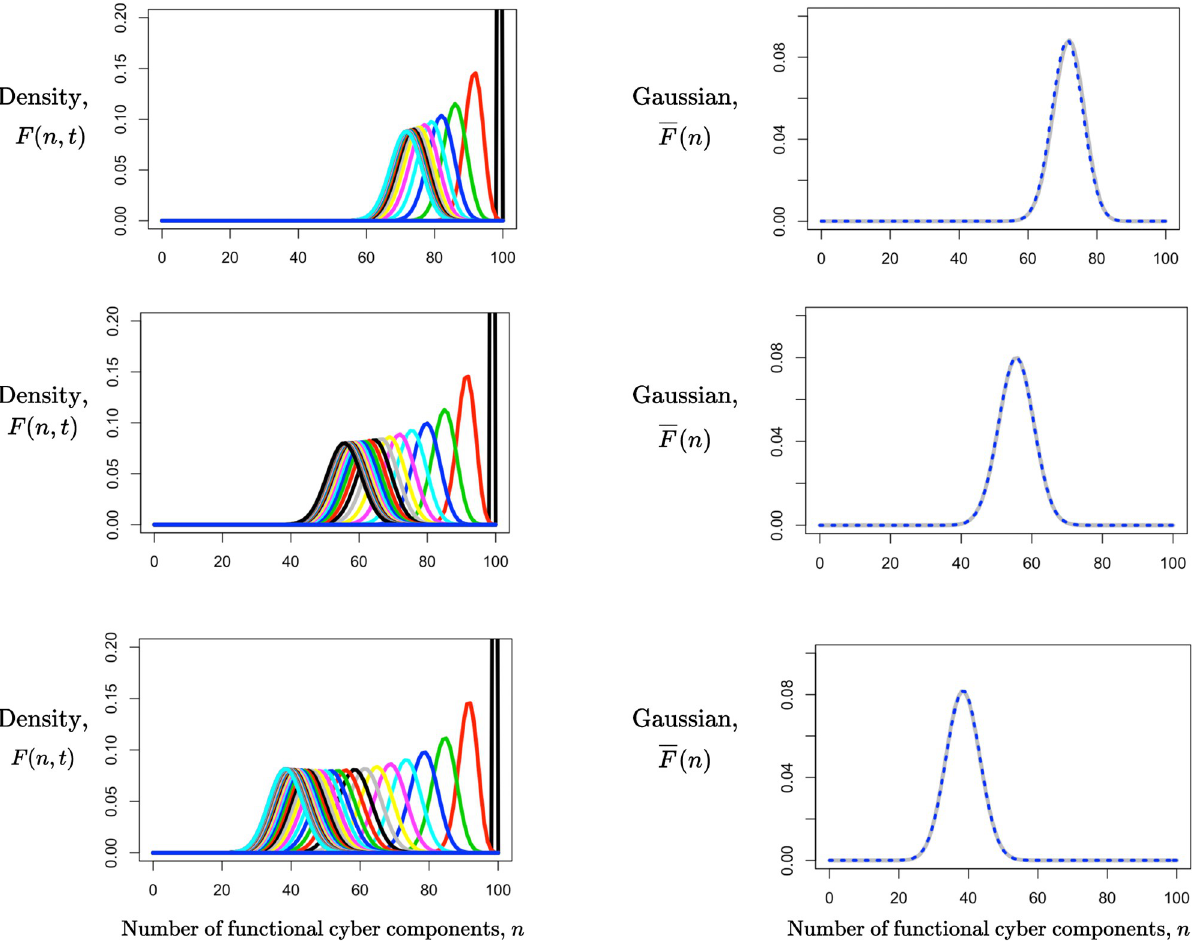
Fig 10. Comparison of the discrete Gaussian approximation and the quasi-steady state solution of the forward equation for the case of N 0 = 100 components, all initially functional. All x-axes correspond to the number of functional components. In the left-hand panels, we show the numerical solution of the forward equation for p = 0.2 and p = 0.08 (first row), p = 0.1 and p = 0.08 (second row), and p = 0.05 and p = 0.08 (third row), du ud du ud du ud marching toward the quasi-steady state solutions. In the right-hand panels, we compare the discrete Gaussian approximation with the densities at t = 20, 40, and 60 (upper, lower, and middle rows, respectively) for the same individual component transition probabilities. The solid gray line corresponds to the densities F ( n , 20), F ( n , 40), and F ( n , 60), and the dotted blue line corresponds to the Gaussian